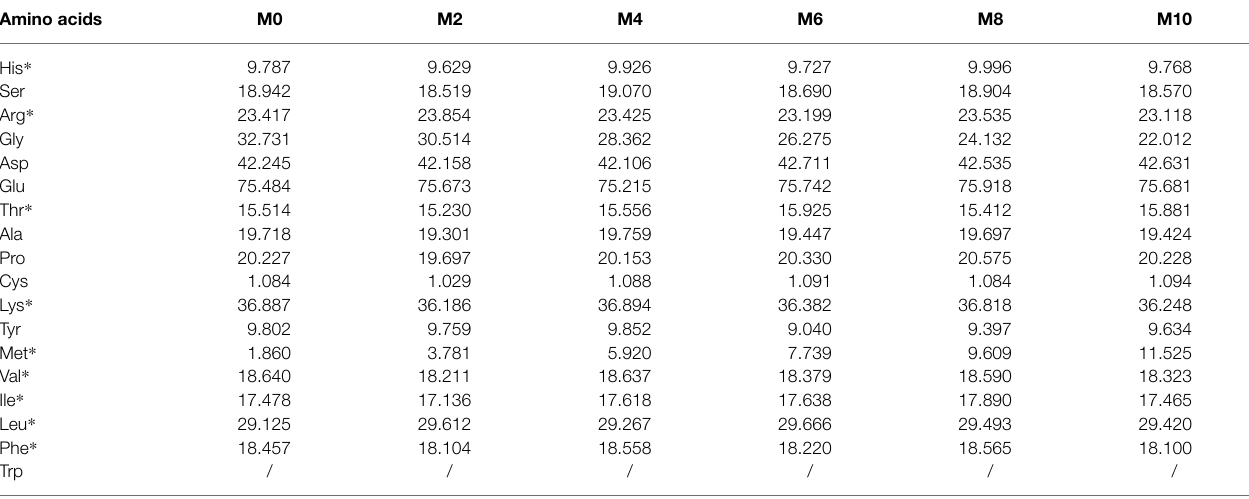
TABLE 2 | The amino acid content (g/kg) of the six experimental diets. Amino